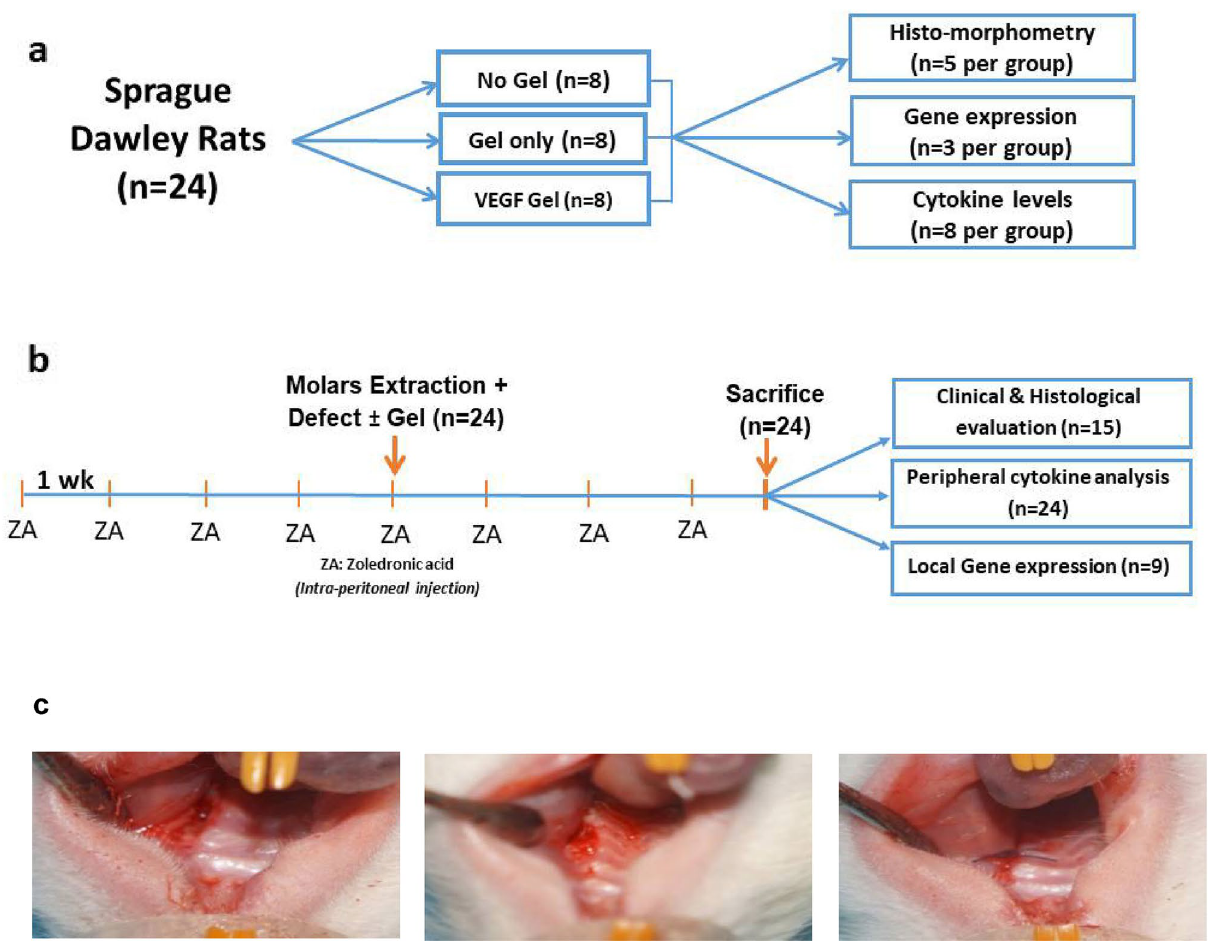
Figure 9. Group allocation of female Sprague Dawley rats for the in vivo study ( a ). Frequency of ZA administration, surgical protocol and timeline for the induction of MRONJ followed by treatment with